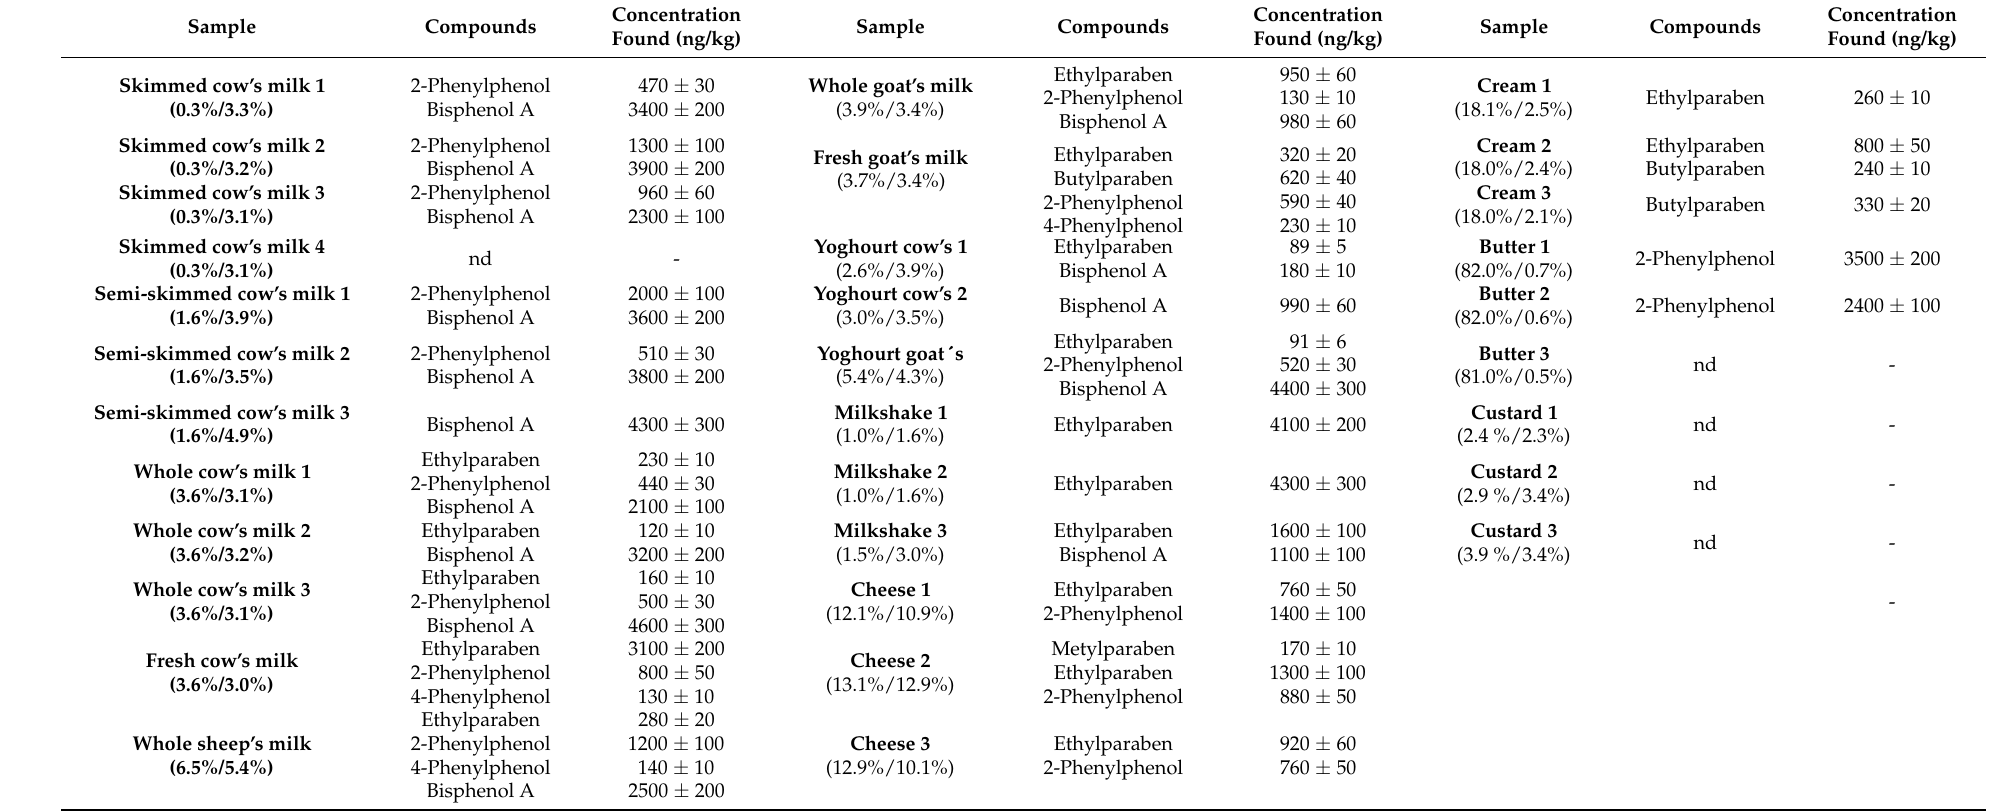
Table 4. EDC contents (mean ± standard deviation, ng/kg, n = 3) found in various types of dairy products a